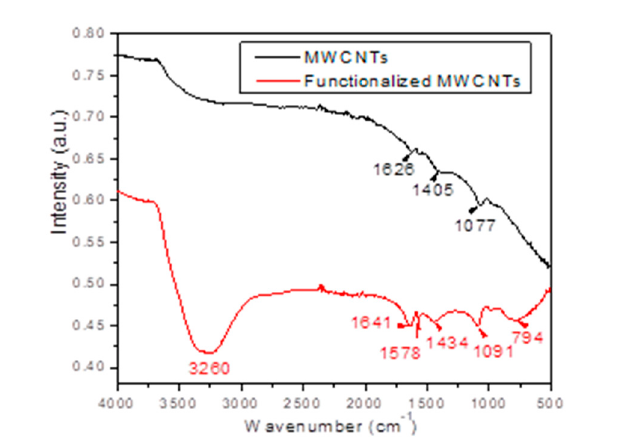
Figure 1. FTIR spectra of the Multi-Walled Carbon Nanotubes (MWCNTs) and functionalized MWCNTs.